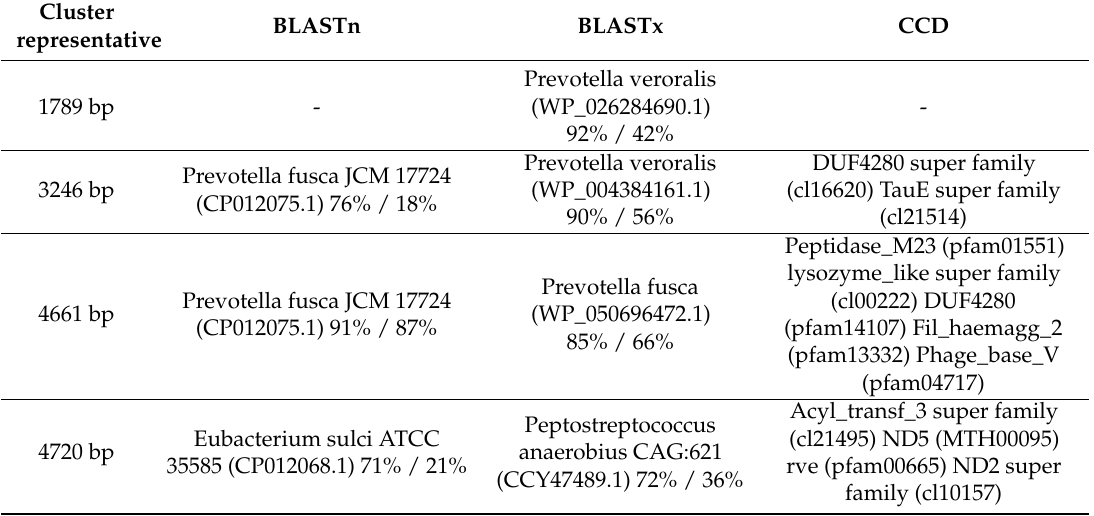
Table 3. Conserved domains of unmapped biological clusters. The cluster representatives of the four unmapped biologically associated clusters were manually searched for sequence similarities and conserved domains via the NCBI web-interfaces BLASTn, BLASTx, and CCD, respectively. Cells containing a dash had no hits with an e-value < 0.001. Cluster representative: Length of the